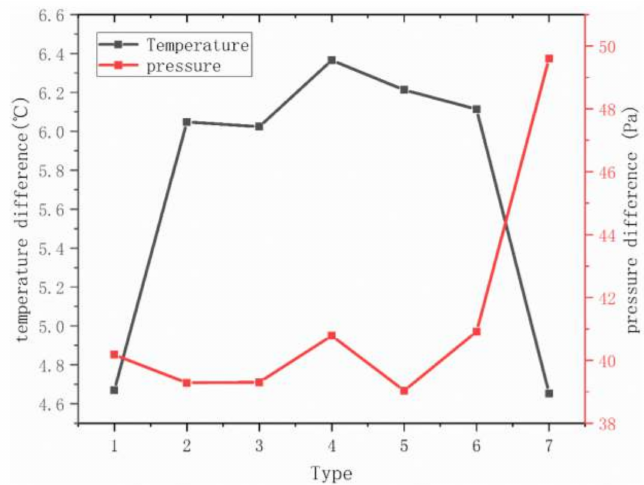
Figure 5. Average temperature di ff erences and pressure drops with di ff erent air deflector designs in